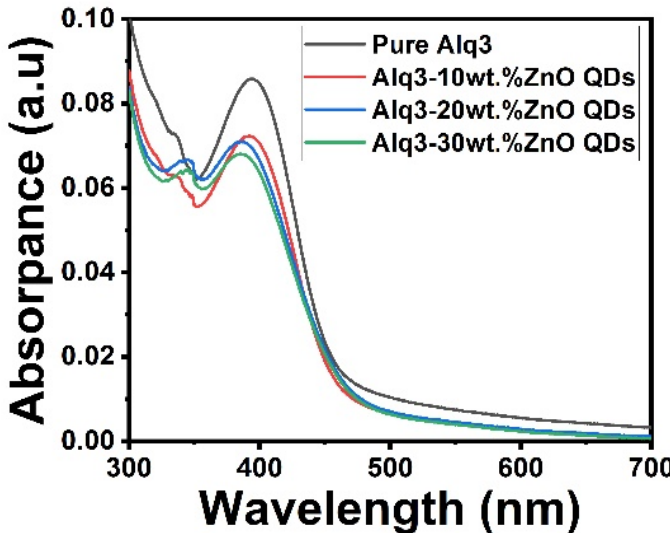
Figure 3. UV-Vis absorption spectrum of pure Alq3 and Alq3-ZnO nanohybrids.